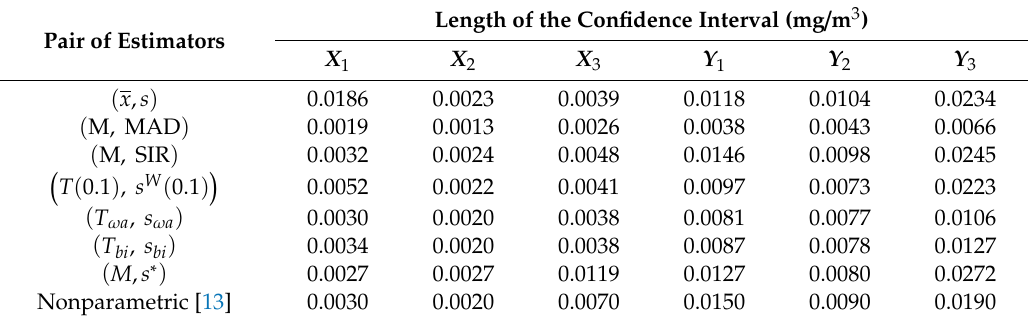
Table 2. The length of the confidence intervals at ( 1 − α ) = 0.95. Pair of